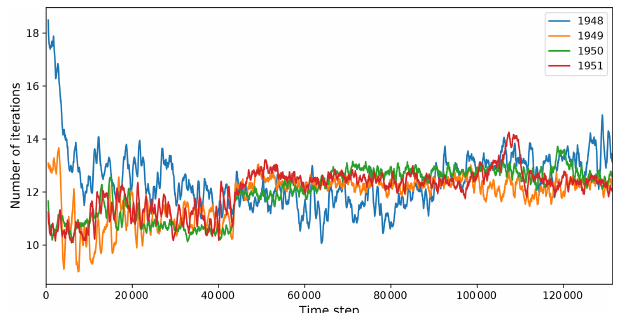
Figure B3. Number of barotropic solver iterations at each time step for four consecutive years. The year 1948 began with the cold start. Running-mean smoothing with window size of 1000 was applied. Ocean model time step was −